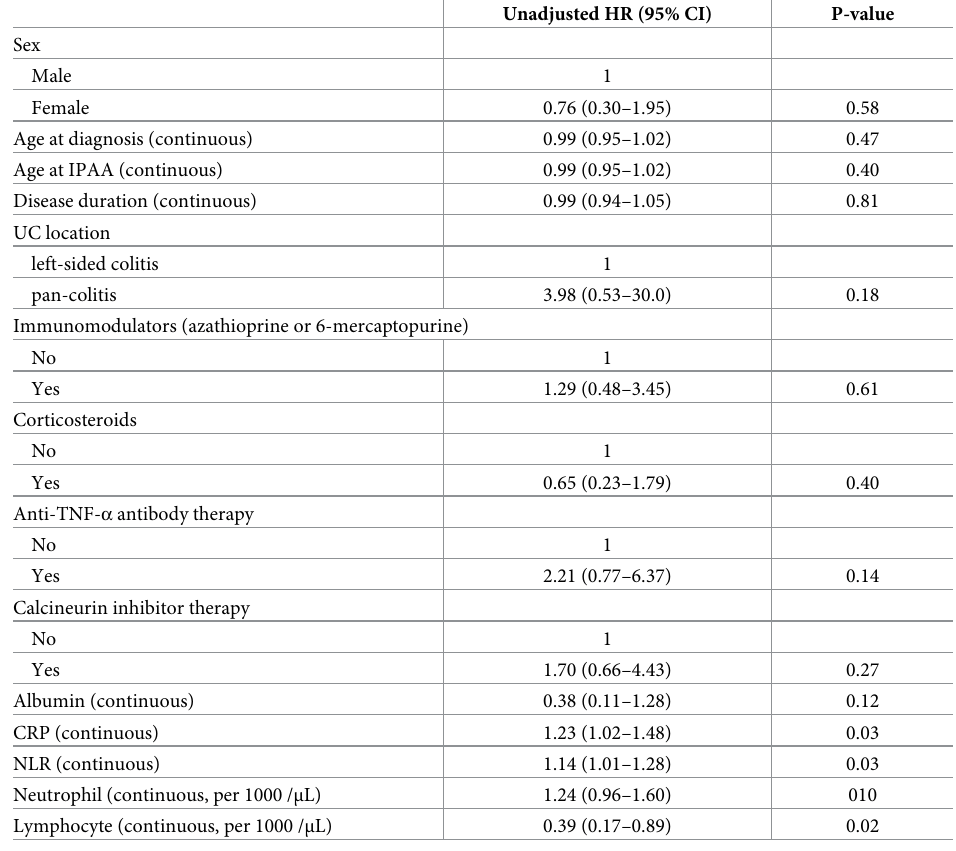
Table 2. Cox regression analysis of risk factors for the development of